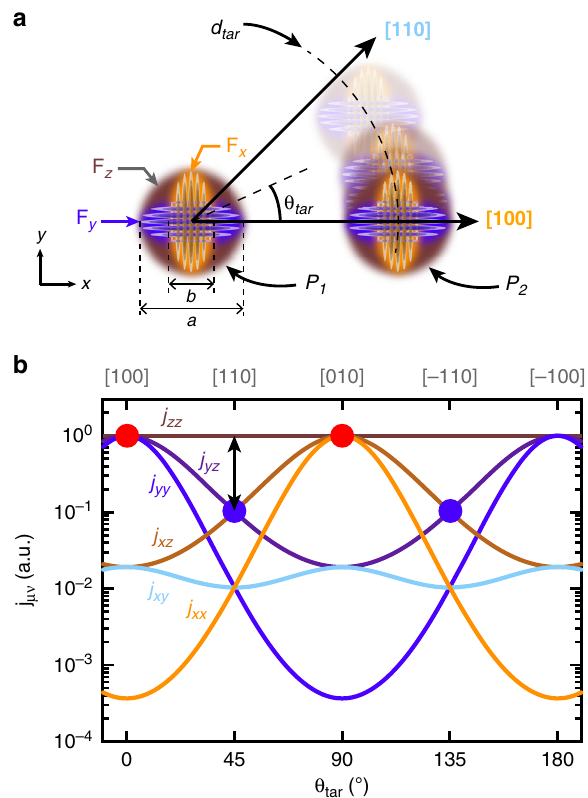
Fig. 6 Donor envelope overlap and exchange interaction. a Two donors placed in the same xy -plane at a target distance d tar and angle θ tar de fi ned from [100]. The exchange interaction can be considered as a sum of valley interfering envelope overlaps j μν between the ± x - (orange), ± y- (purple) and ± z -valleys (brown). The mass anisotropy results in each envelope orbital, F x , F y or F z , to be constricted along its own direction. For instance, F x has a small envelope radius b along x , and a large envelope radius a along y and z . b Normalised envelope weights j μν plotted vs. θ tar for d tar = 12 nm, using b / a = 0.52 and a = 2.8 nm. Because of orbital anisotropy, the j yy , j yz and j zz terms (respectively j xx , j xz and j zz terms) are degenerate and dominate around [100] (respectively [010], red spots), while j zz dominates around [110] and [ − 110] (blue